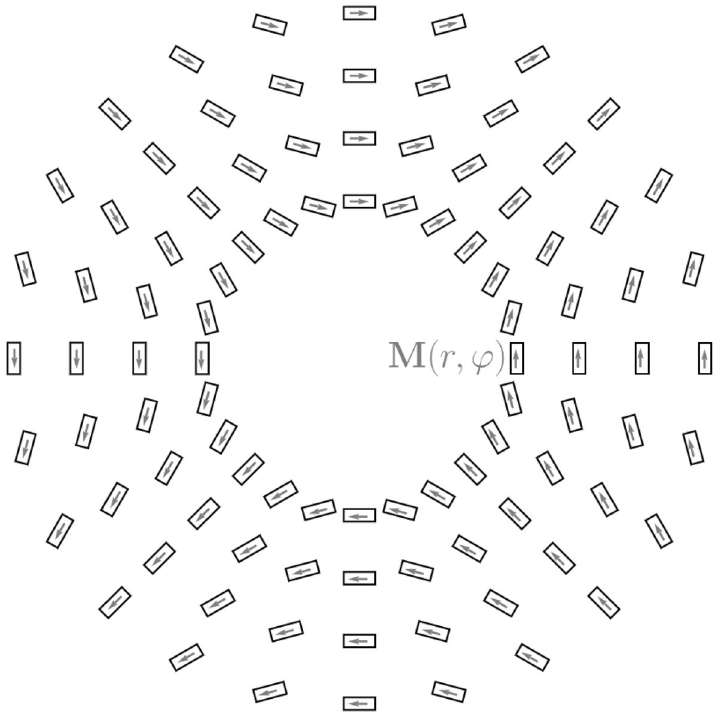
Figure 10. Top view of the magnetization direction (arrows) ( M ( r , ϕ) ) of the individual STEs, which is stabilized by intrinsic magnetic interaction (such as the shape anisotropy). The topology of the emitted THz fields at the center of the texture remains basically preserved (but with accordingly enhanced intensity) when the basic central unit (shown also in Fig. 1) is periodically repeated with a larger radius as to enclose the micrometer-sized